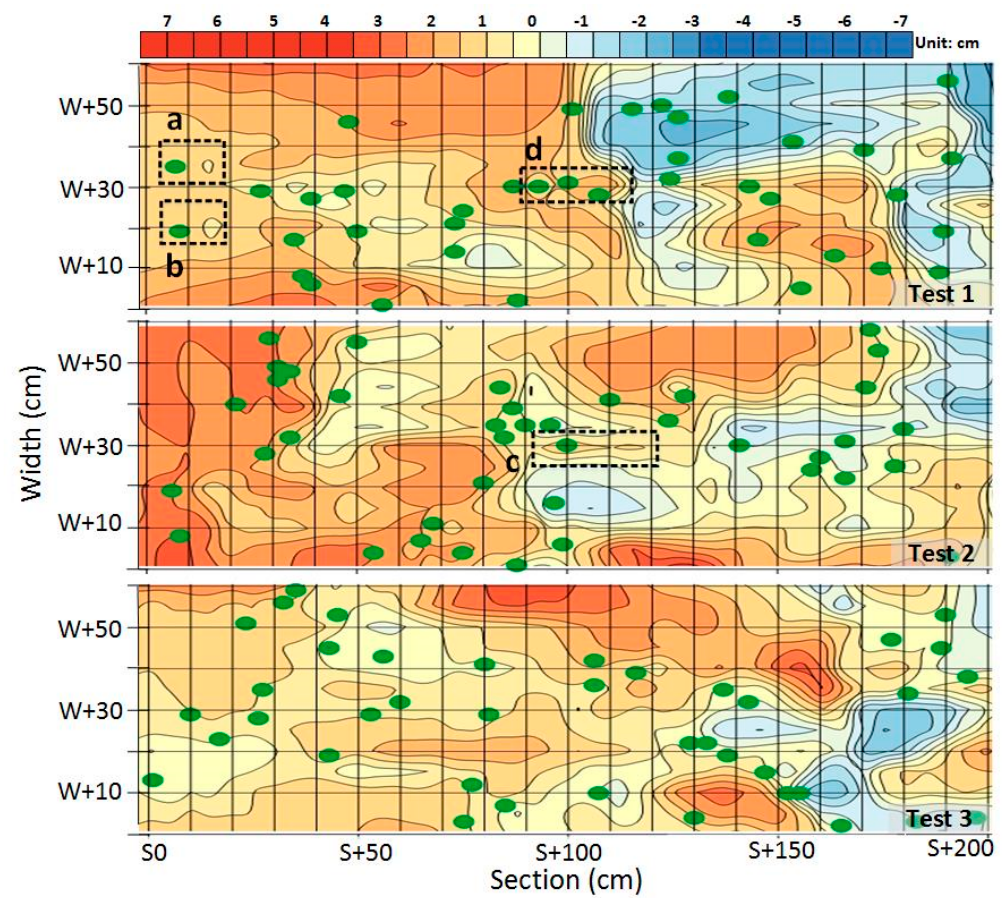
Figure 3. The contour map of channel topography after the 33.33 stems/m 2 experiments (test 1–3); ( a ) scouring stage, ( b ) development stage, ( c ) recovery stage, ( d ) deposition stage. Green dots represent vegetation.